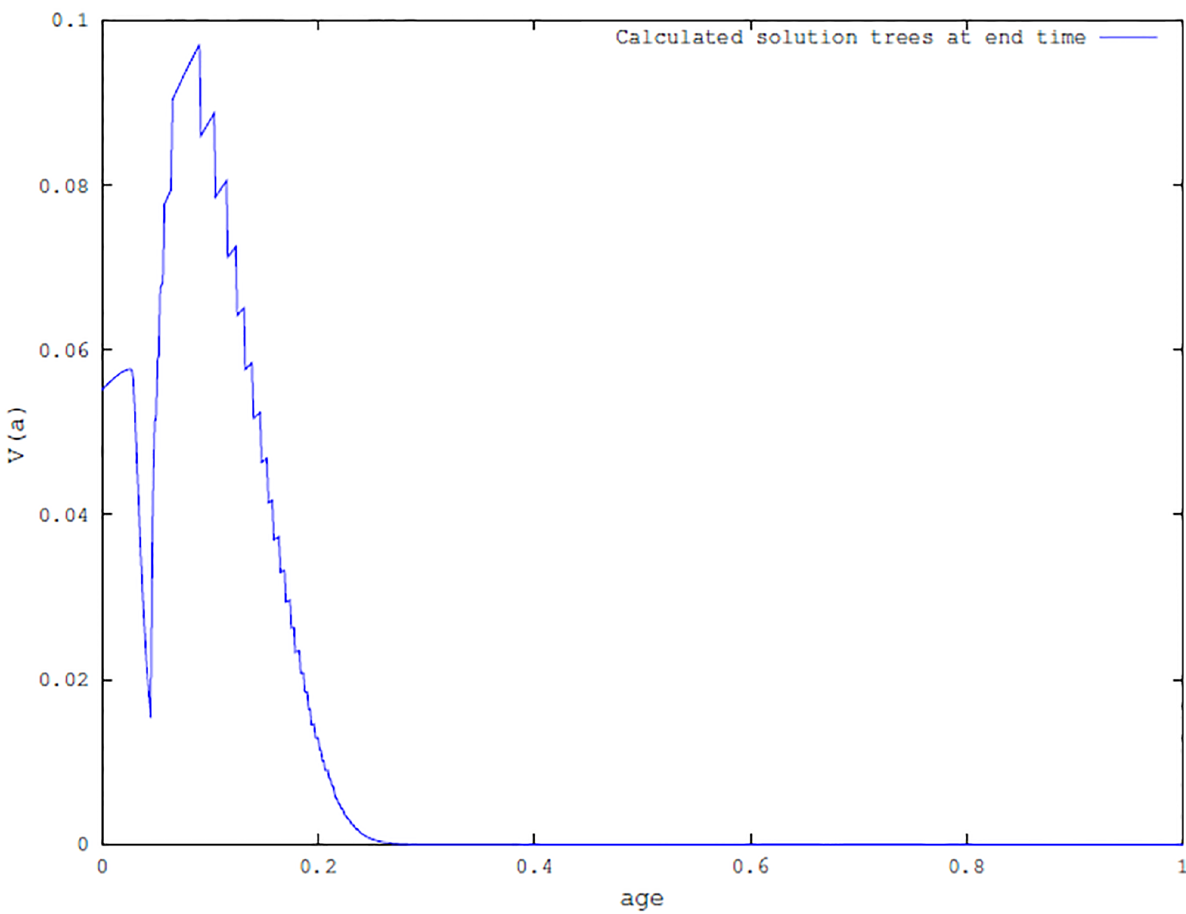
Fig 5. Number of trees at the end time t = 1 (corresponding to 350 years) when beetles are in the epidemic state. Results from simulation of the optimal control problem P1 with u max = 100 and ω 1 =